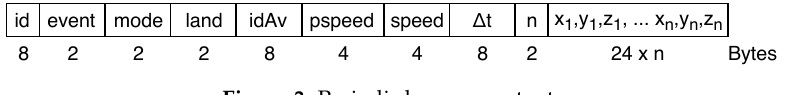
Figure 3. Periodic beacon